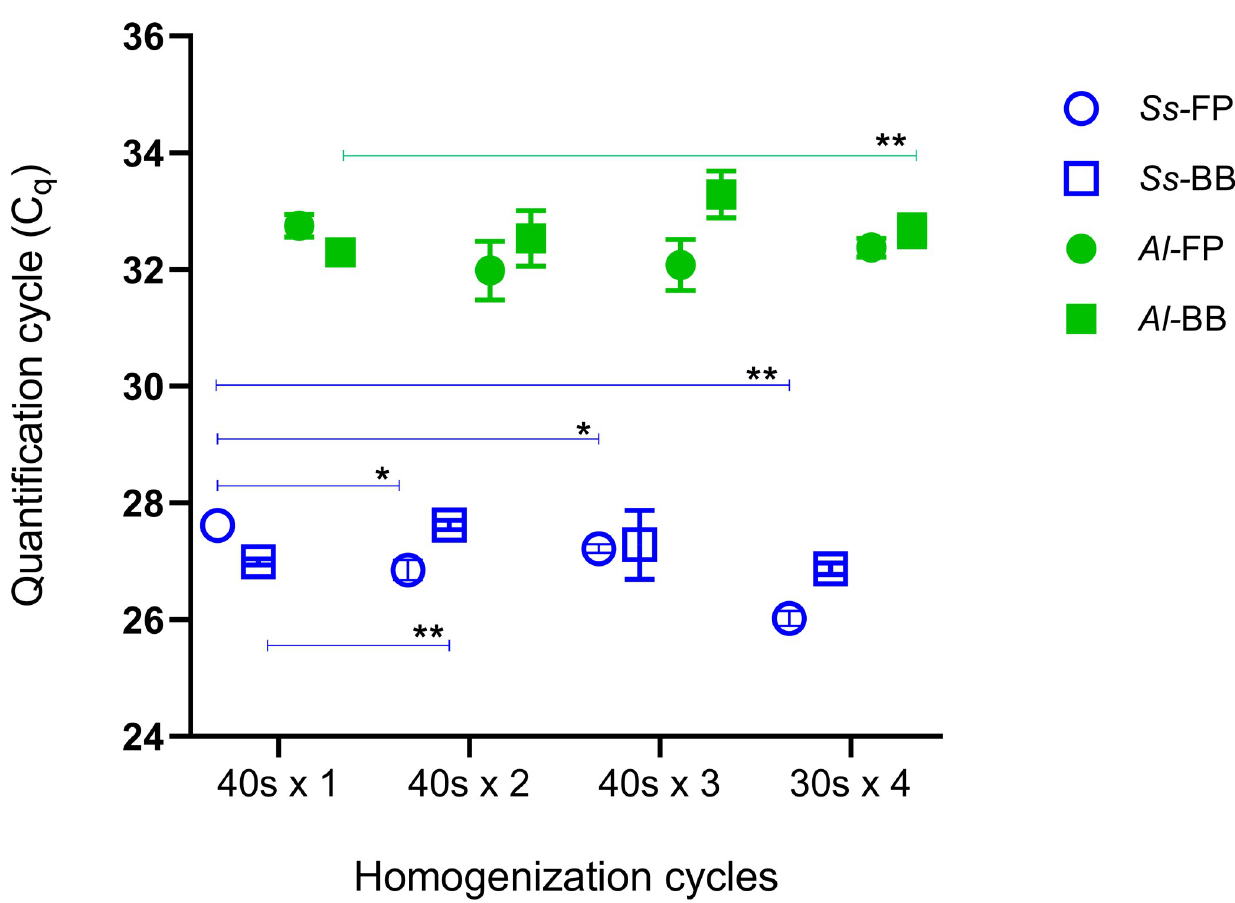
Fig 3. Comparison of two homogenisers for DNA extraction. The FastPrep-24 ™ 5G (FP) and Mini-Beadbeater-24 (BB) were used in conjunction with the Isolate II Fecal Kit to detect S . stercoralis ( Ss ) larvae and A . lumbricoides ( Al ) extracted from human stool by qPCR. Stool was equally divided into 8 aliquots and extraction was performed on either the FP or BB. Four different cycling times were tested using each homogeniser and the STH1 qPCR was performed in triplicate to ascertain mean C q s and standard deviations. � p < 0.05; �� p < 0.005 using paired t tests.